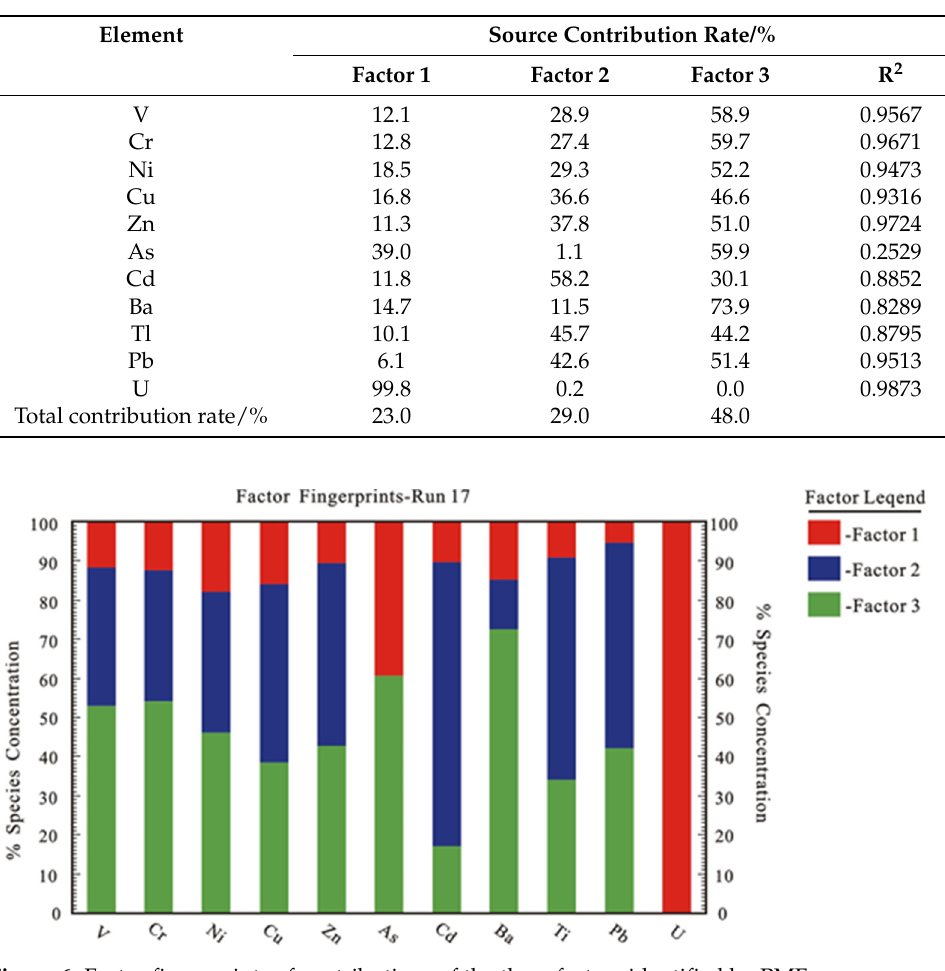
Figure 6. Factor fingerprints of contributions of the three factors identified by PMF. Table 2. Contribution rate (%) results of each factor and element as calculated by the PMF model.). Element